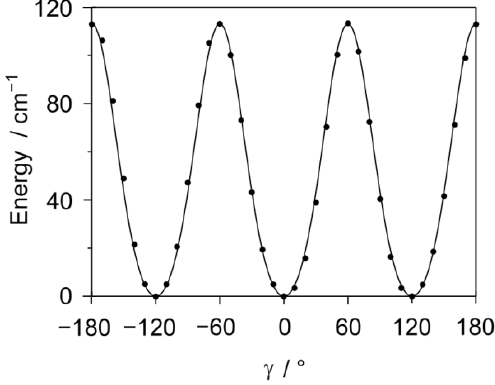
Figure 4. The threefold potential obtained by rotating the methyl group about the C 13 -C 14 axis (variation of the dihedral angle γ = ∠ (O 15 -C 13 -C 14 -H 16 )). The optimized structure of conformer I a served as the input structure. Three equivalent minima were obtained for γ = − 120°, 0°, and 120°. The torsional barrier of about 113 cm − 1 is relatively low, suggesting large torsional splittings in the microwave spectrum. Energies are given relative to E min = − 458.9577608 E h .